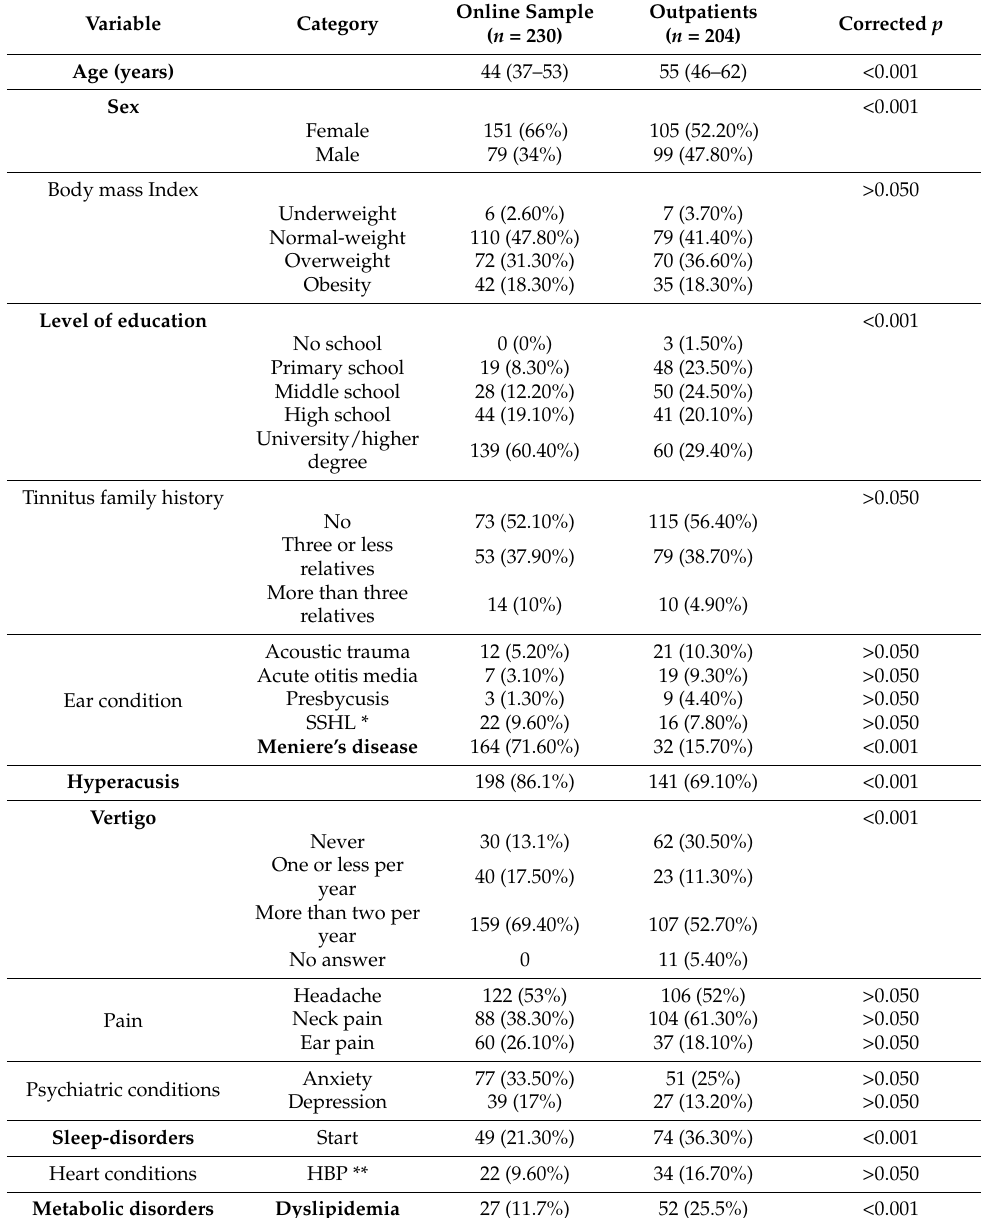
Table 1. Demographic data and comorbid conditions for online sample and outpatients with chronic tinnitus ( n =